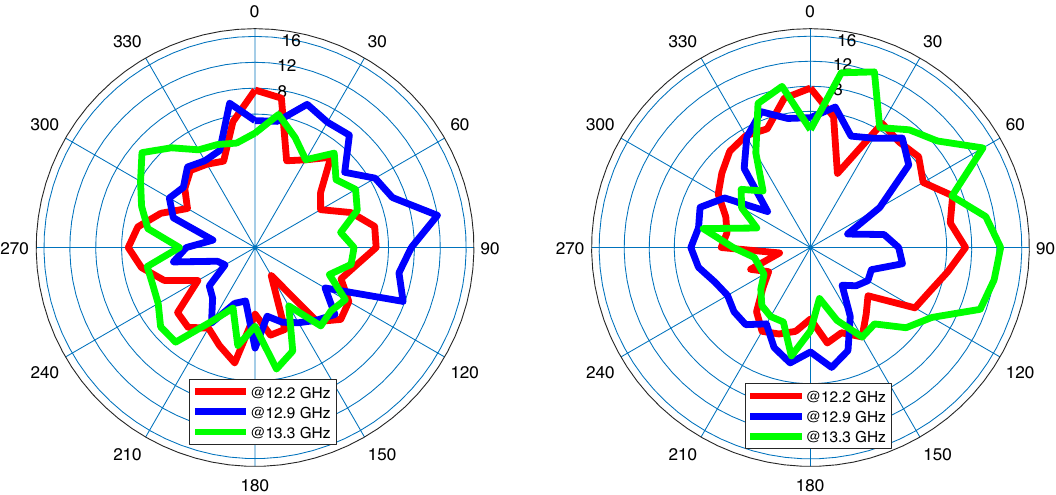
Figure 14. Radiation pattern of simulation antenna-2 at f 1 = 12.2 GHz (red), f 2 = 12.9 GHz (blue), and f 3 = 13.3 GHz (green); φ = 0 (left), φ = 90 ◦ (right).